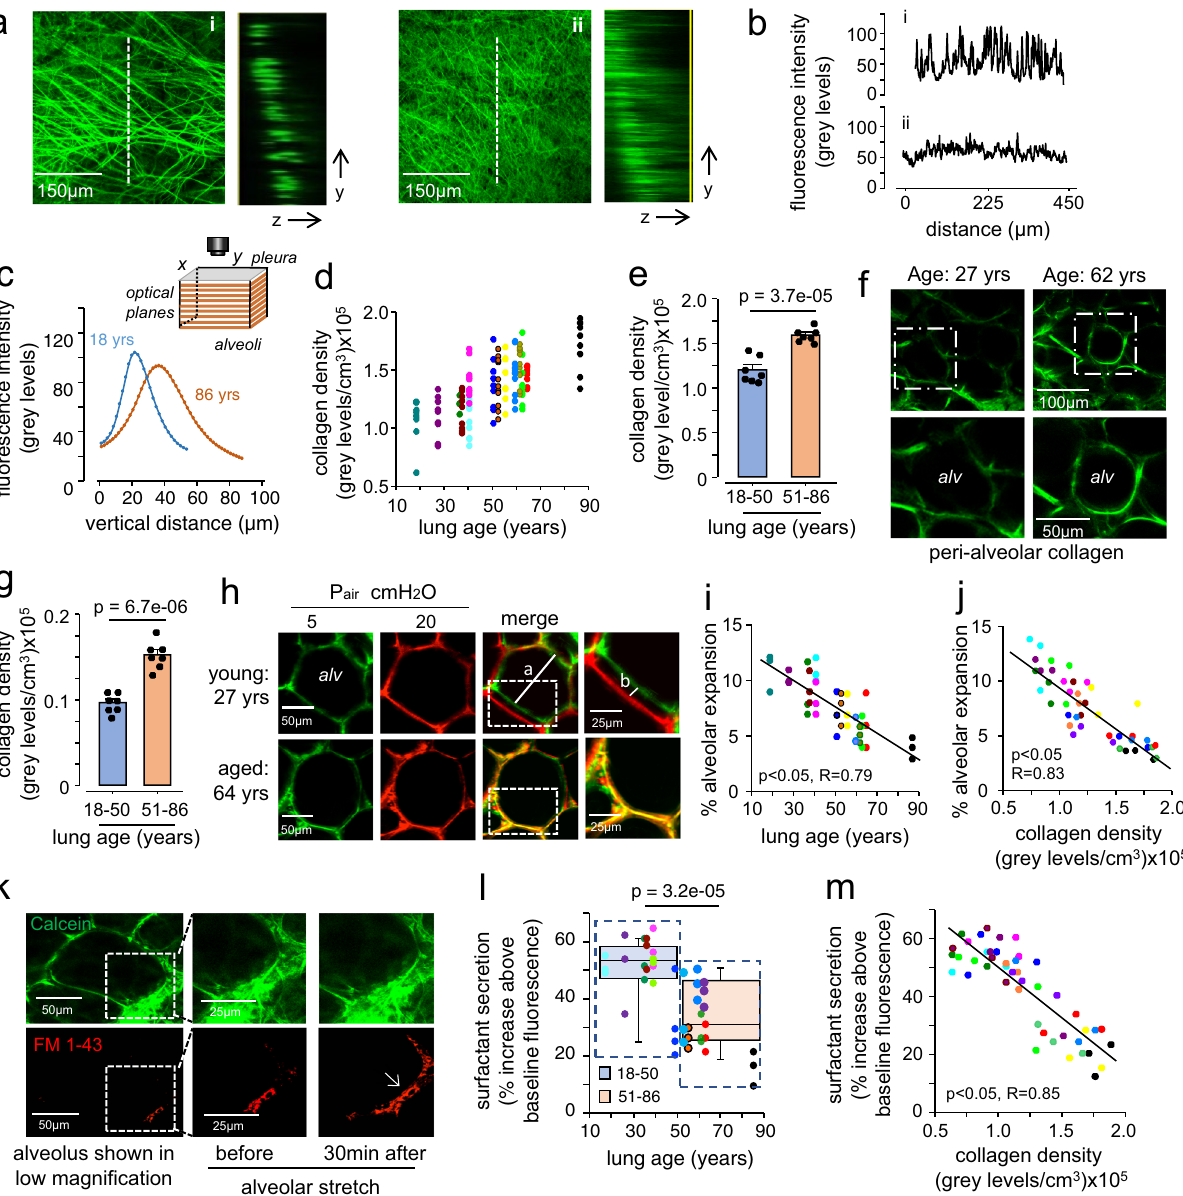
Fig. 4 Aging-associated fi brosis limits alveolar expansion and surfactant secretion. a , b Two-photon images (i and ii) show collagen fl uorescence by second harmonic generation in the subpleural interstitium of an 18 (left) and an 86 (right) year-old lung. Adjacent panels show collagen fl uorescence in the depth plane (y-z) along the indicated lines (dashed lines). Tracings in ( b ) represent fl uorescence intensity along the lengths of the dashed lines ( “ distance ” ). c – e Imaging was carried out across a tissue volume calculated as the product of the area and the depth of the imaged fi eld (see sketch). Tracings in ( c ) are from two representative fi elds and quantify collagen fl uorescence along the depth axis from the pleural margin. In ( d ) “ collagen density ” was calculated as the summed fl uorescence per unit volume for multiple fi elds in each lung. (Each color indicates a separate lung.) Group data are shown in ( e ). f , g Images and group data show peri-alveolar collagen. h Confocal images show an alveolus (alv) stained with the intracellular dye, calcein-AM. Alveoli were imaged at alveolar pressures 5 (green) and 20 cmH20 (red). The alveolar diameter at 5 cmH2O is marked by the line “ a ” . The septal displacement at 20 cmH2O is marked by the line “ b ” (see a magni fi ed image of the region selected by the rectangle). i , j Alveolar expansion was calculated from the distances of the lines exempli fi ed in h , as (b/a)%, and plotted for individual imaged fi elds against donor age ( i ) and subpleural collagen densities ( j ). k The images show an alveolus stained with calcein-AM (green) and the extracellular lipid dye FM1-43 (red). A selected region (rectangle in left image) was magni fi ed in the middle and right images. Alveolar stretch caused surfactant secretion as indicated by a time-dependent increase of red fl uorescence (arrow). l , m Plots show determinants of surfactant secretion. For a : determinations replicated 9 times in an 18- and an 86-year-old lung gave similar results. For e and g : data were mean ± SEM; n = 7 lungs each group; P value is for two-tailed Student ’ s t -test. For i , j , l , and m : each dot shows the response for a single alveolus. For f , h , and k : determinations were repeated in seven lungs in each group. For i , j , and m : P values were computed by linear regression. For boxplots in l : the middle line shows the median, the lower and upper hinges are the fi rst and third quartiles, the lower and upper whiskers extend to the value at most 1.5 IQR below the fi rst quartile or 1.5 IQR above the third quartile, respectively, the data beyond the ends of the whiskers are outlying points, and the P value shown is for two-tailed Student ’ s t